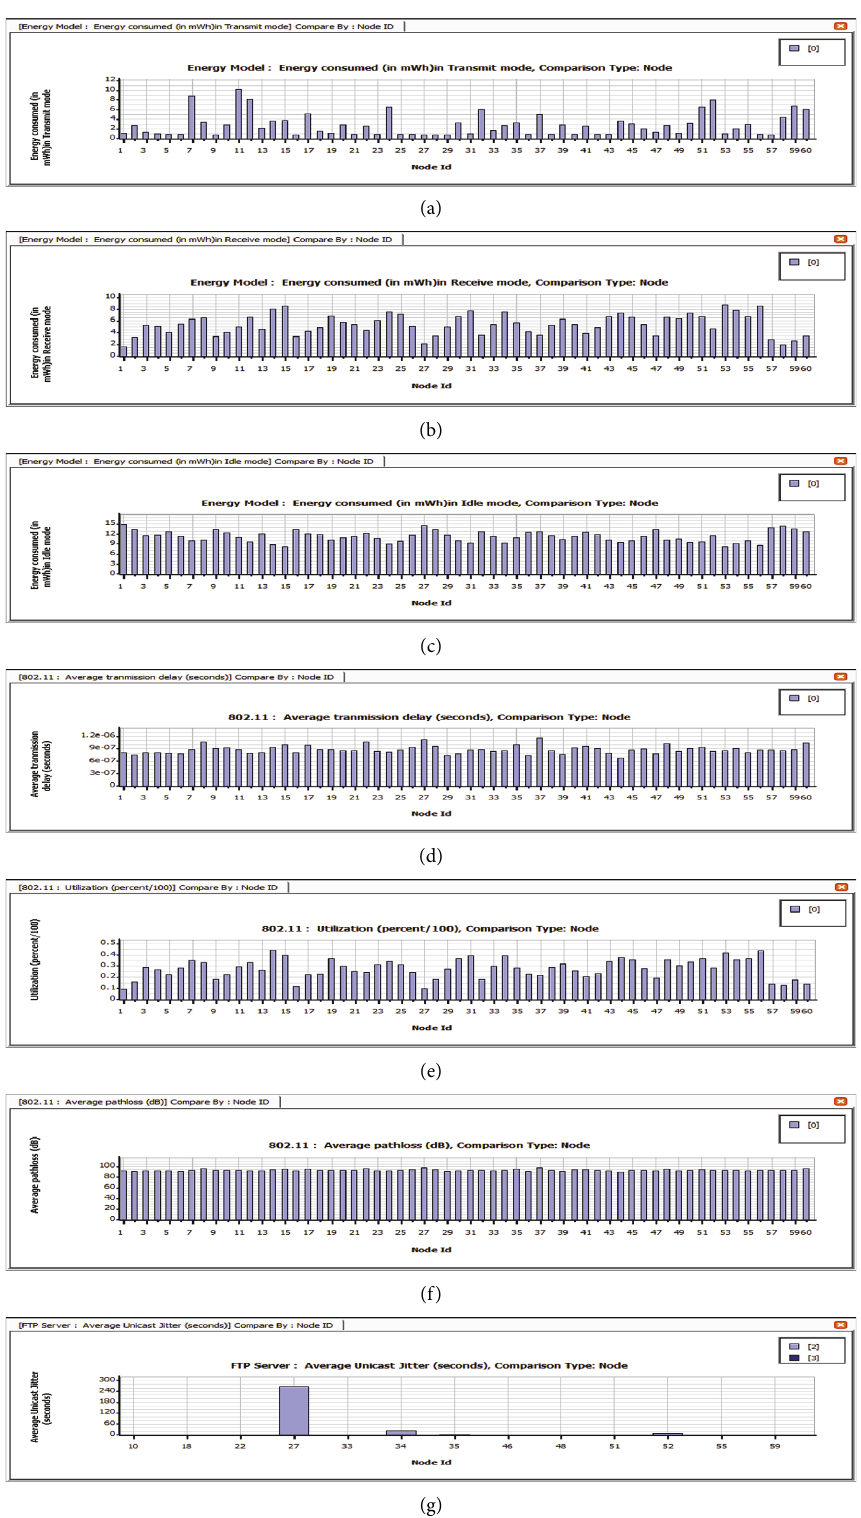
Figure 12: (a) Transmit mode energy consumption of OLSR for FTP deployment. (b) Receive mode energy consumption of OLSR for FTP deployment. (c) Idle mode energy consumption of OLSR for FTP deployment. (d) Average transmission delay of OLSR for FTP deployment. (e) Percentage of utilization of OLSR for FTP deployment. (f) Average pathloss of OLSR for FTP deployment. (g) Average jitter of OLSR for FTP